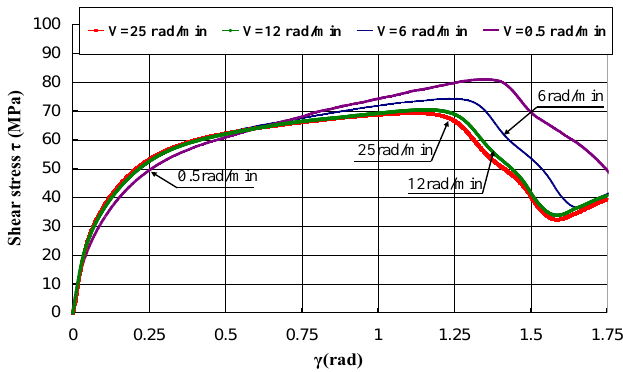
Figure 5. Torsion tests of